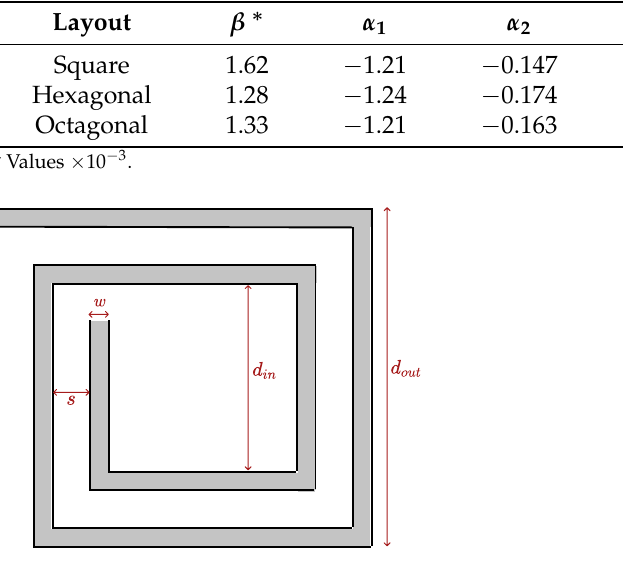
Figure 1. Square coil model for the approximation